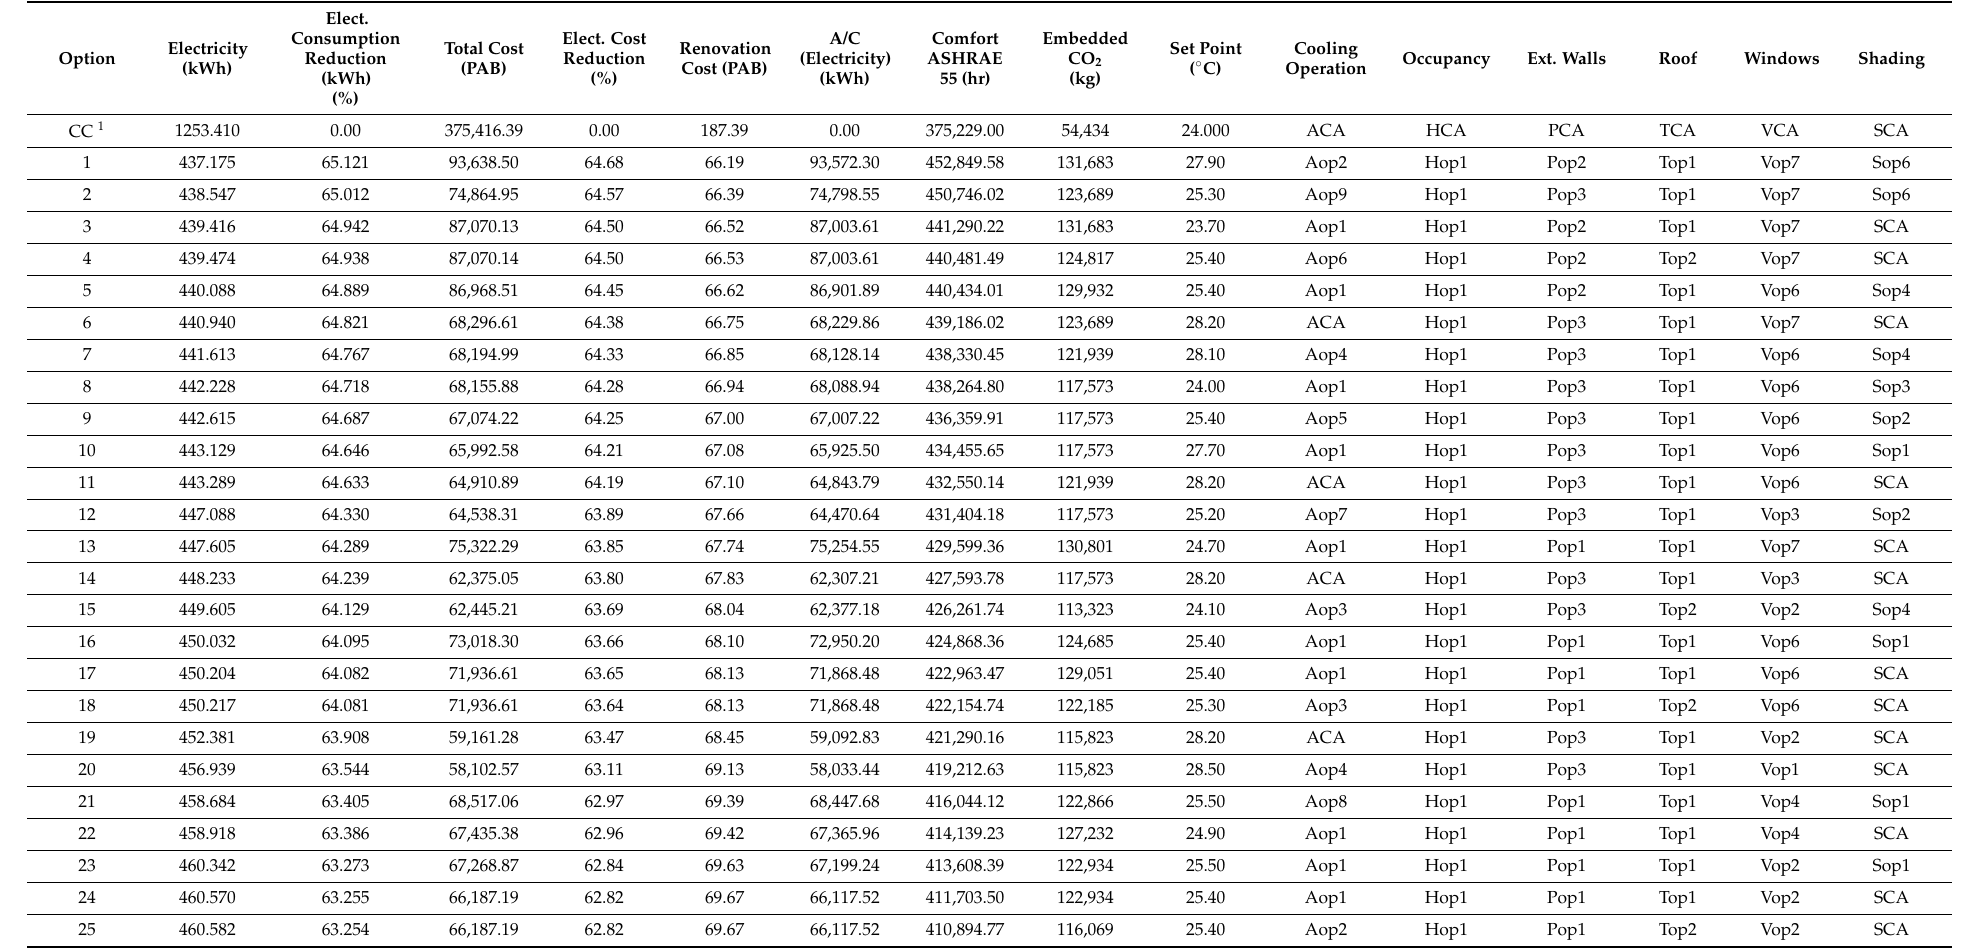
Table A1. Simulation results of the model in its current condition and multi-objective optimization analysis with the values obtained for each factor considered and their respective design